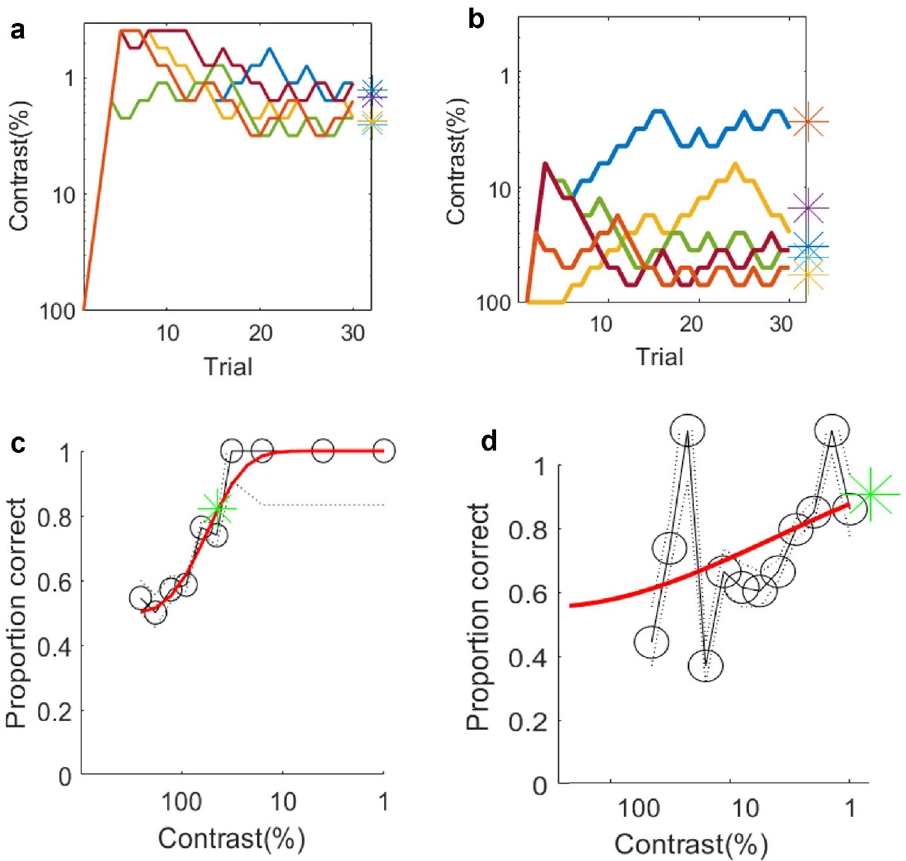
Figure 5. Examples of the staircases in the top row and their corresponding Weibull fits in the bottom row, a good weibull fit ( a , c ) and a poor fit ( b , d ). The different colored curves in the plots a and b represent five staircases from one subject for the same spatial frequency and disparity condition. Response data from trials in all five staircases were combined into a single psychometric function and fit with a Weibull 32 to estimate the alpha value, corresponding to 82% correct performance. The red curves on the plot in the bottom row show the Weibull fit to the raw data, shown with the grey curves and circular symbols. The green asterisks are the alphas of the fits and were used as threshold estimates. The alpha in the poor fitting staircase corresponds to a contrast greater than 100%. Cases where a fit was unreliable are marked in the plots of Figs. 2 and 3 as open magenta